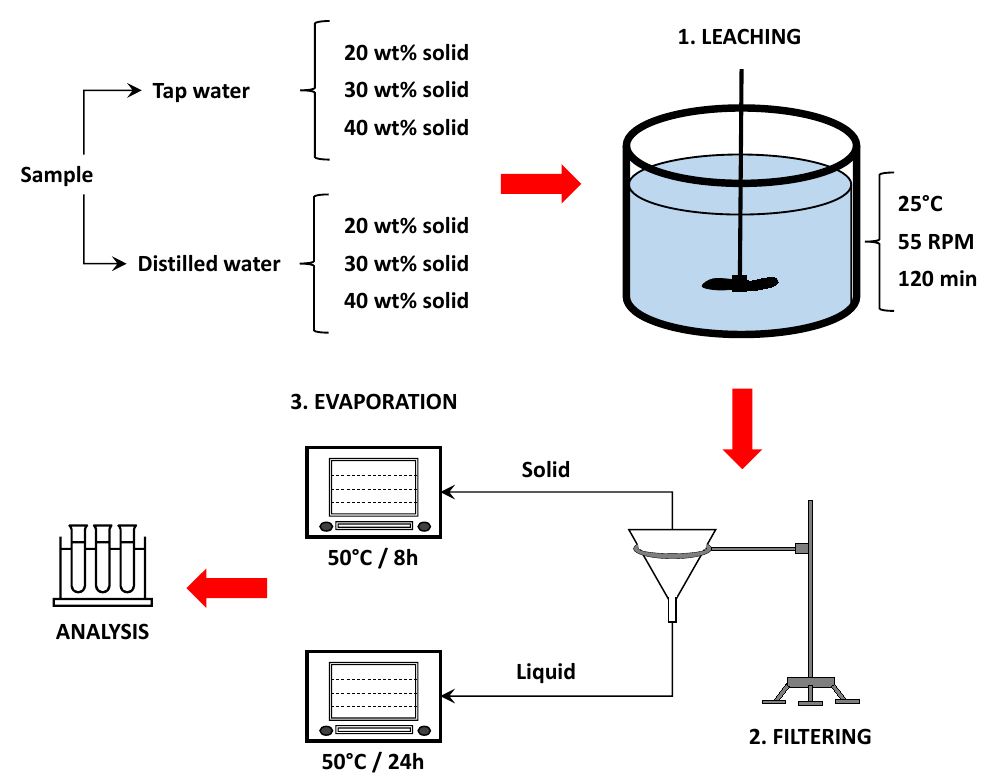
Figure 3. Procedures and conditions used in leaching essays.